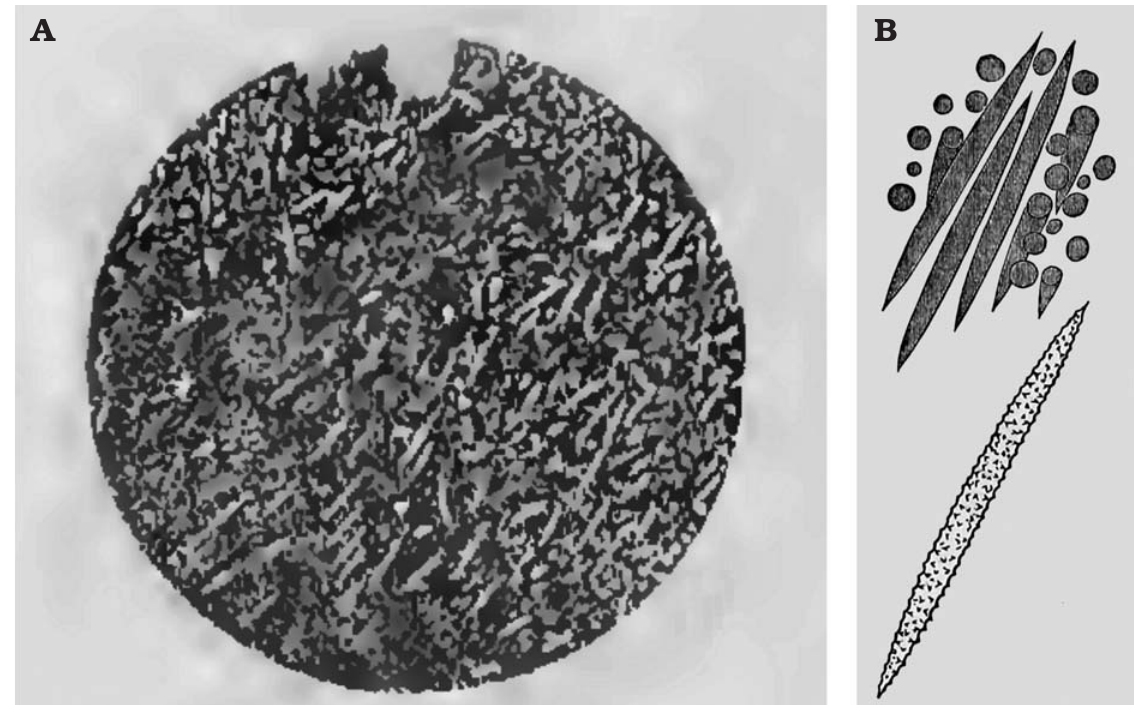
Fig. 12. Spongilla purbeckensis Young, 1878, Spongillida: Spongillidae; Purbeck Limestone, Lower Cretaceous, Stare Cove, Dorset, England. A . Spicules in the spiculite as illustrated by Hinde (1883). B . Spiny oxeas in the drawing of Young (1878). Originally not to scale; it may be inferred from the text that spicules are 450 μ m long.